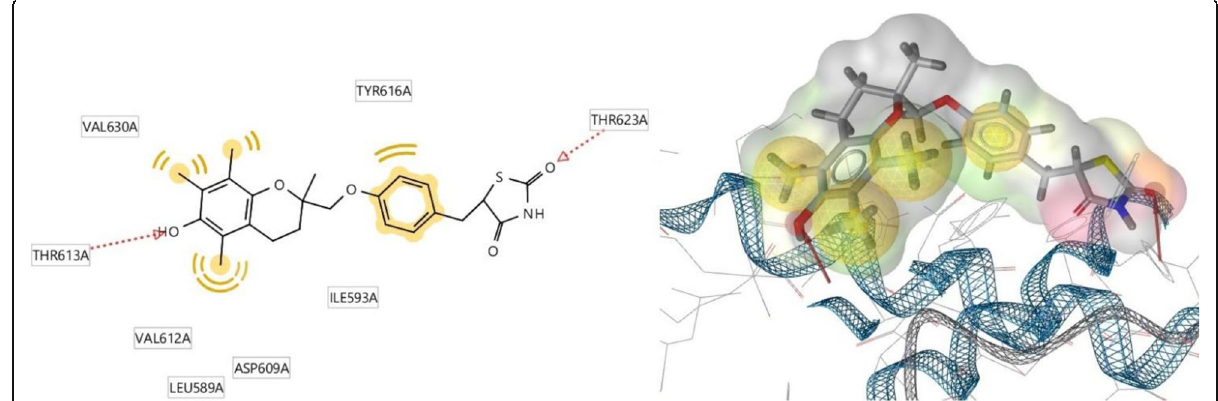
Fig. 6 The binding mode of Troglitazone within the active site of 5VA3. The hydrogen bonds are presented in red-dotted